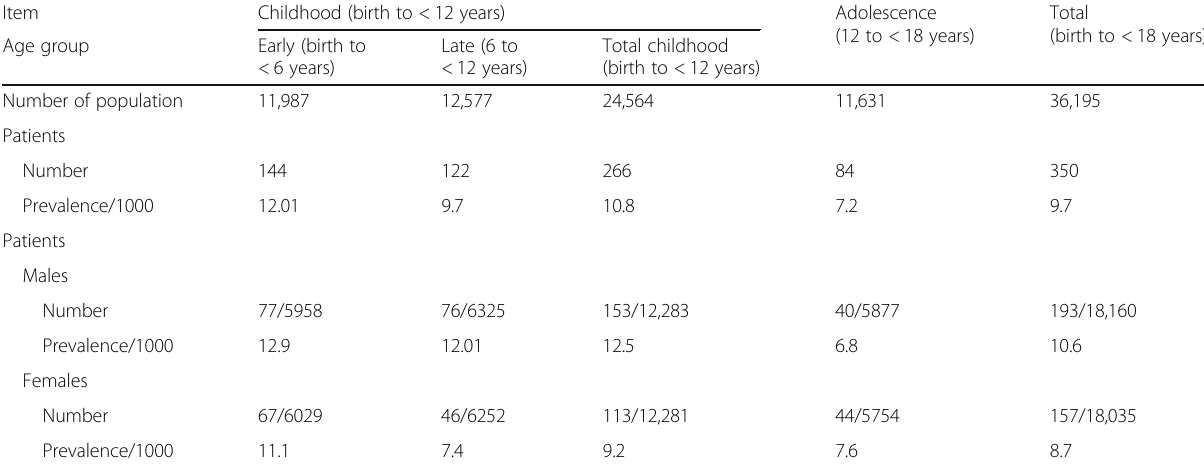
Table 1 Age- and sex-specific prevalence of childhood and adolescence epilepsy Item